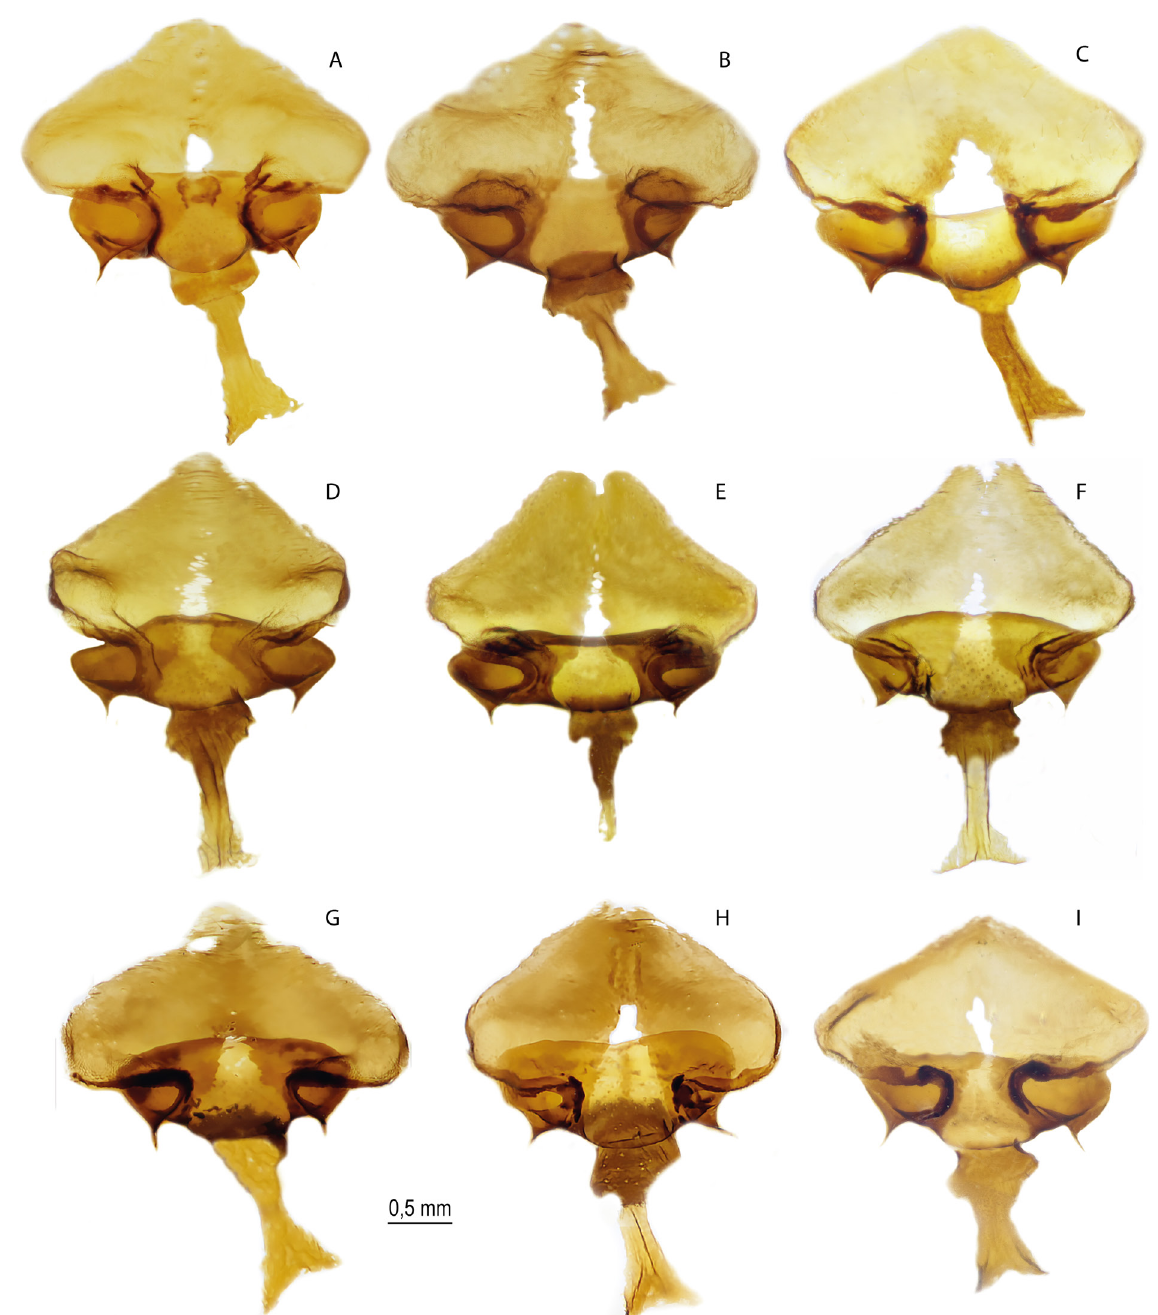
Fig. 11. Female genitalia (without the anal papillae, copulatory bursa, and anterior and posterior apophyses). A–C . Melitaea timandra timandra Coutsis & van Oorschot, 2014, S Turkmenistan,